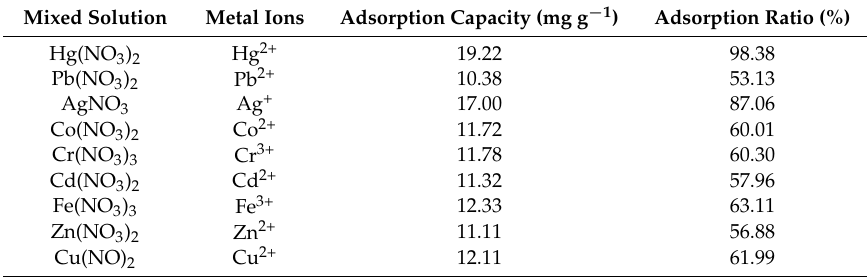
Table 3. Competitive adsorption of nine metal ions onto 50 mg of PBT at 25 ◦ C in 50 mL solution at the same initial ion concentration of 20 mg L − 1 for each metal ion for 24